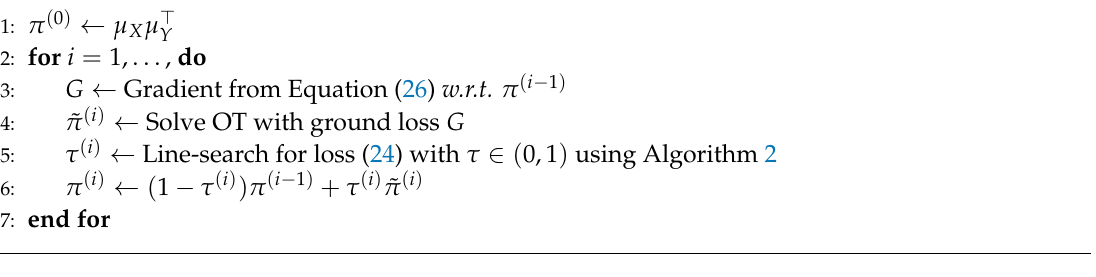
Algorithm 1 Conditional Gradient (CG) for FGW